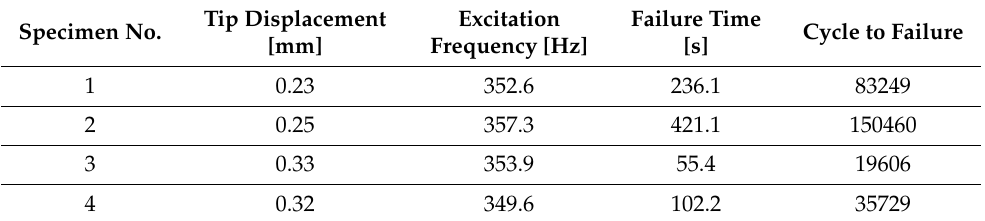
Table 7. Endurance tests results for the Diamond specimen.